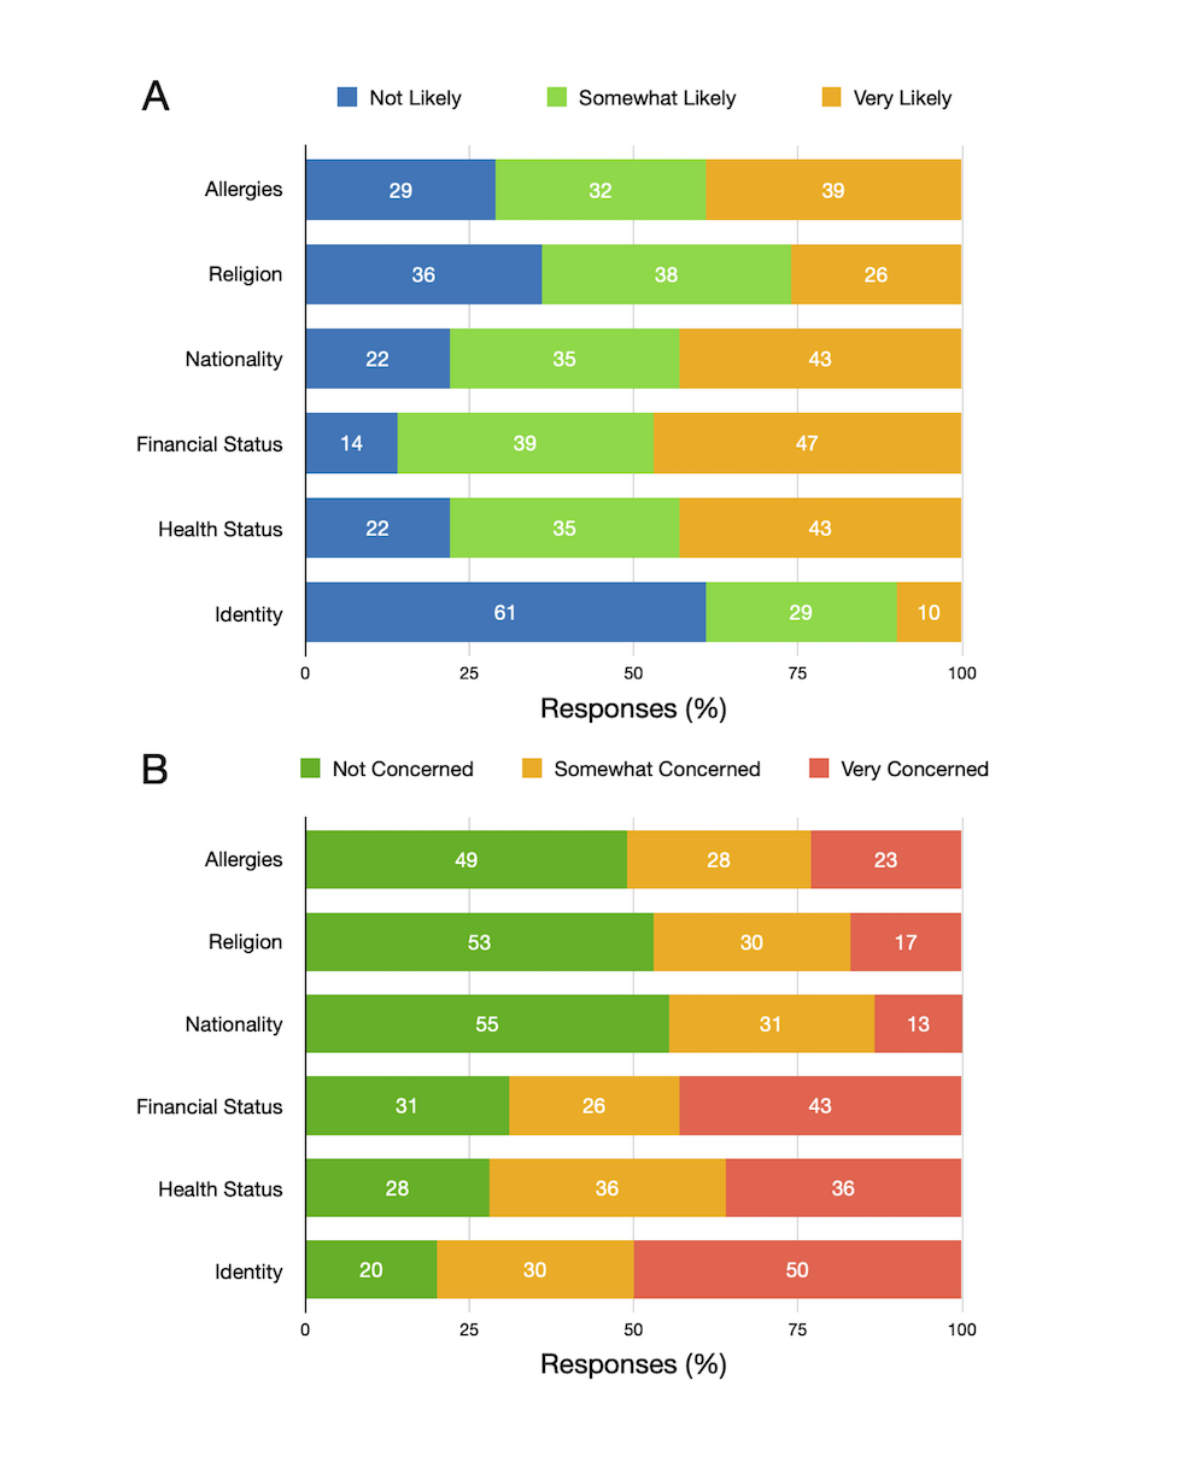
Figure 2. A. Perceived inference from image-based dietary assessment data set; B. Concerns toward a third party learning such attributes. The values in the graph indicate the percentage of